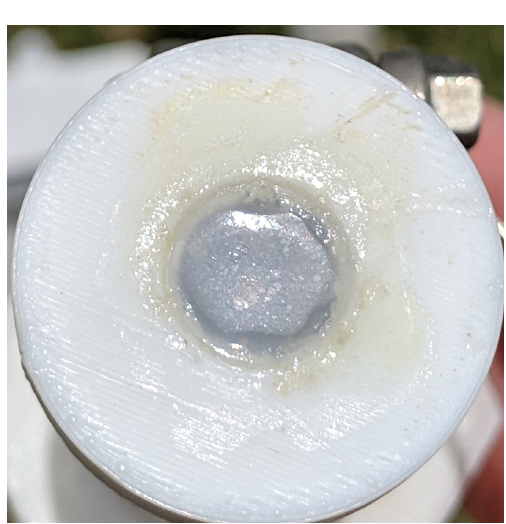
Figure 1. Ultraviolet index sensor using a plastic covering cut from a freezer meal tray. This image taken at the end of the campaign shows yellowing of the glue used to seal the